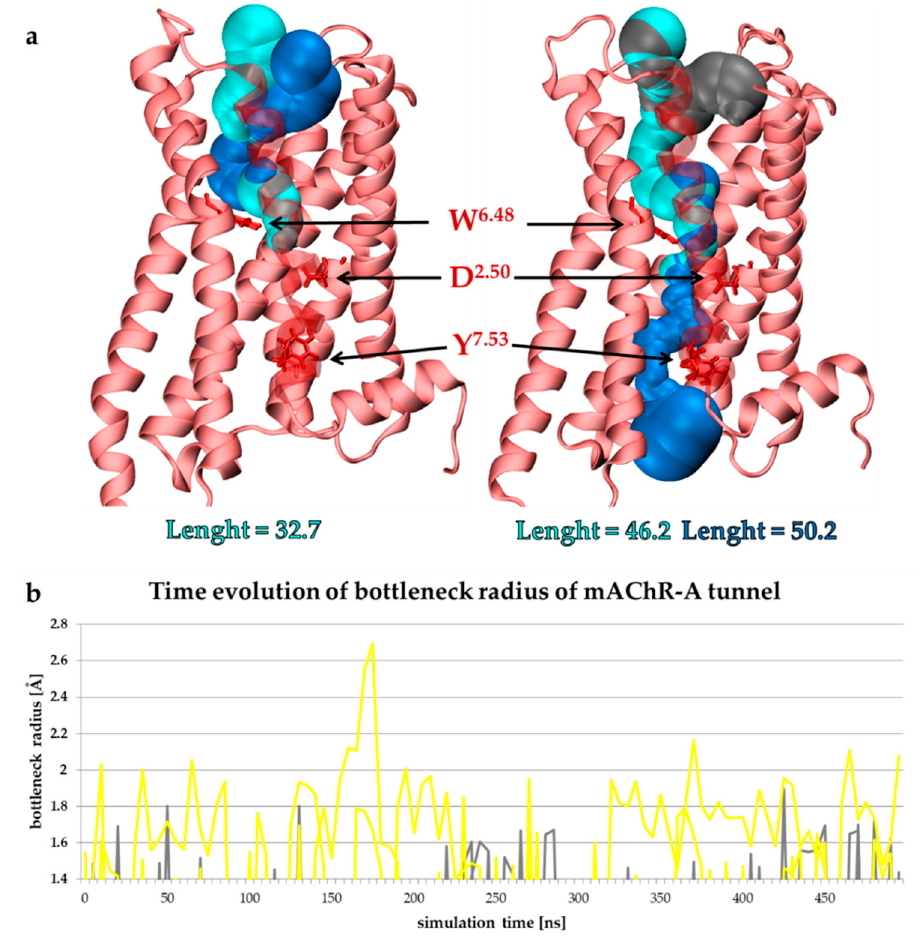
Figure 10. ( a ) Tunnels were found in insect mAChR-A receptor at the minimized and equilibrated structure (left) and in the representative MD snapshot of the receptor with BQCA-azo-IR3535 ligand. ( b ) The bottleneck radius of the tunnels created below the ligand-binding site allows water flow (i.e., with the bottleneck radius higher than 1.4 Å). In gray, the tunnels found in the 3 × 500 ns MD of the APO mAChR-A are shown, while in yellow, those found in the receptor with the bound BQCA-azo-IR3535. Tunnels were visualized using MOLE 2.0 [62], and the bottleneck analysis was performed with CAVER [63].